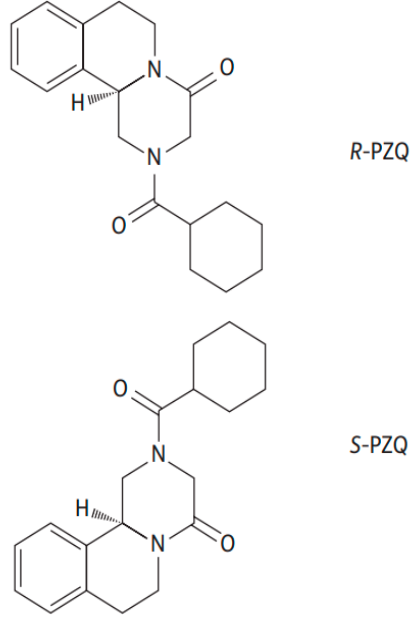
Figure 3. The chemical structure of R-PZQ and S-PZQ enantiomers [38].